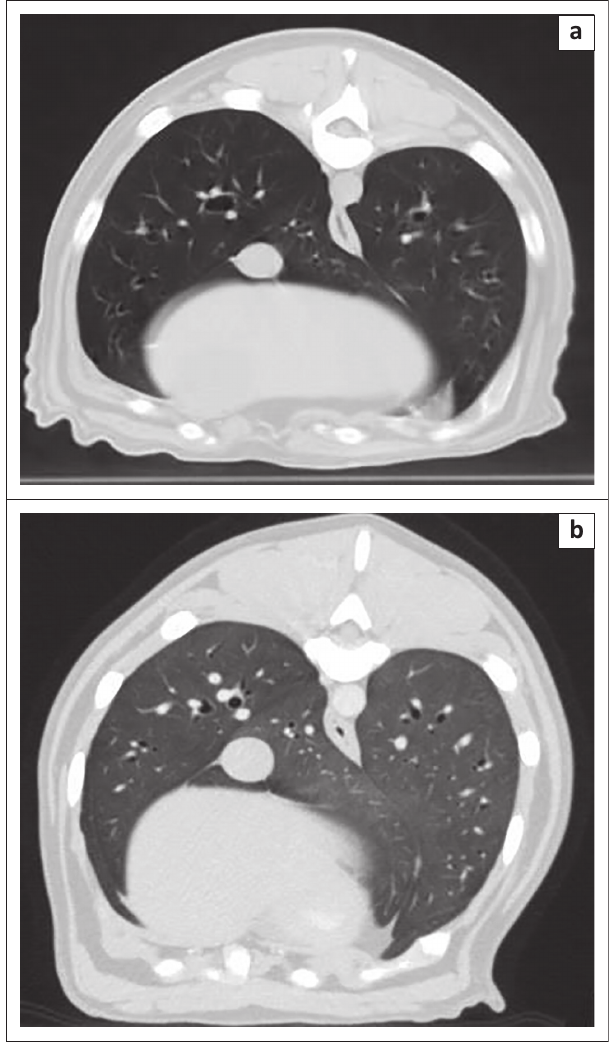
FIGURE 4: (a) Normal canine lungs and (b) ground-glass appearance of patient’s lungs W 1465 C